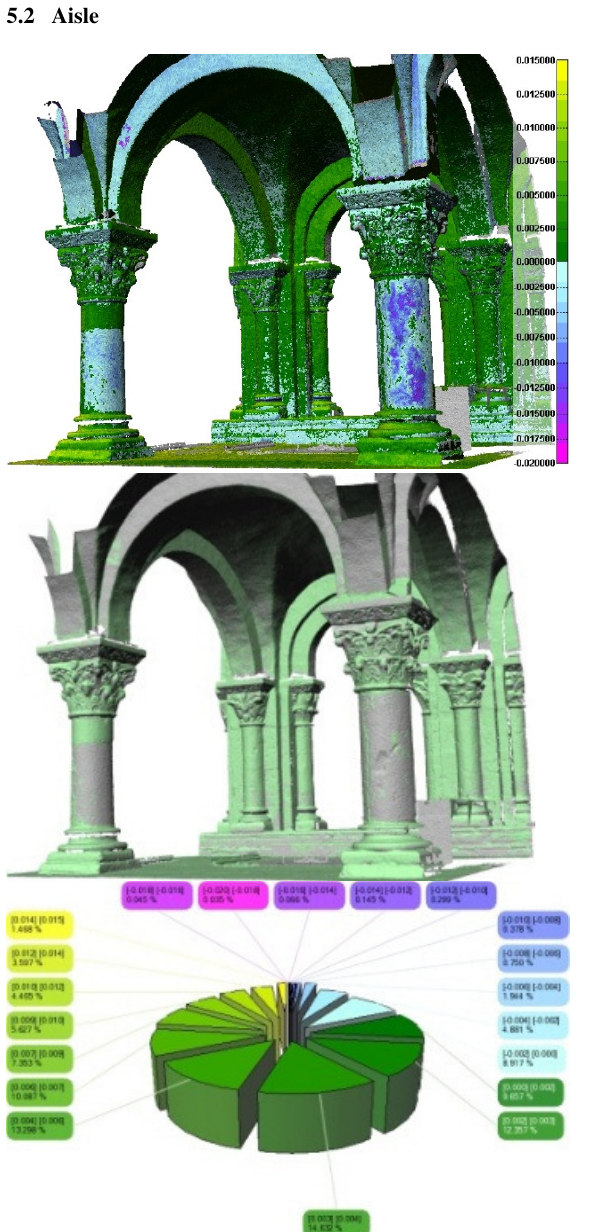
Figure 6. Error-map color mode, per scanner color mode and pie-type error distribution chart for subproject 2.